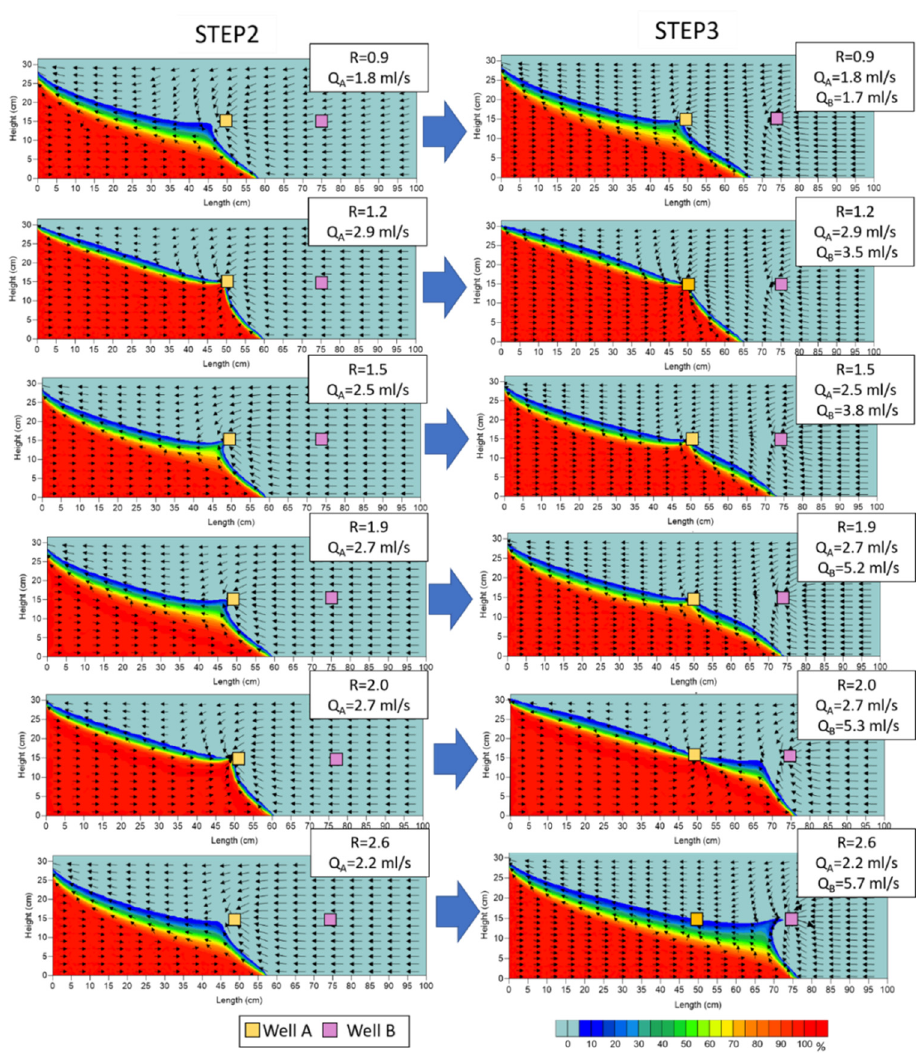
Figure 10. Comparison of steady states at Steps 2 and 3.